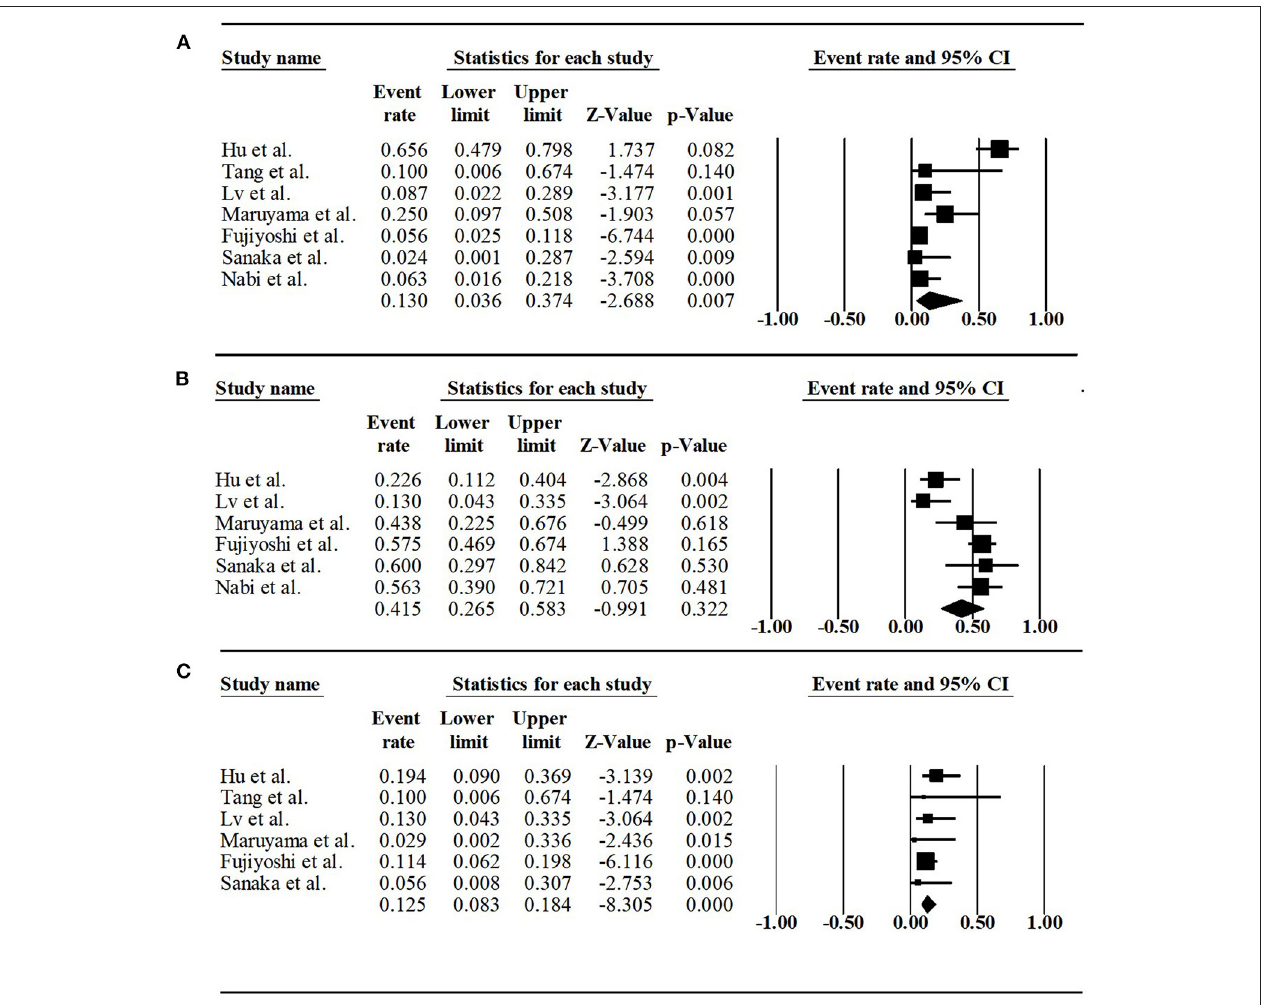
FIGURE 4 | (A) Forest plot of adverse event rate of POEM for sigmoid-type achalasia. (B) Forest plot of rate of objective confirmation of reflux after POEM for sigmoid-type achalasia. (C) Forest plot of symptomatic reflux rate of POEM for sigmoid-type